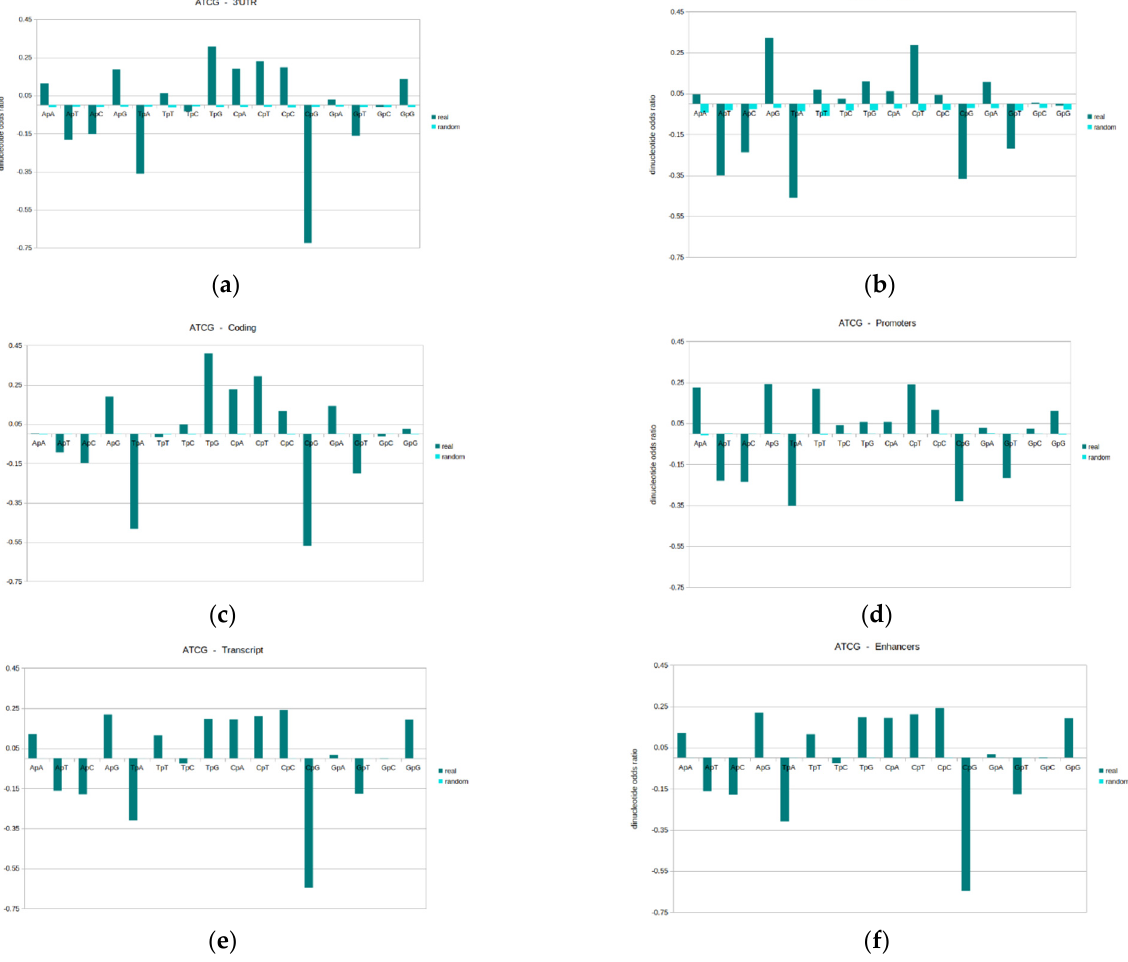
Figure 4. General designs profiles for the original ATCG sequence, according to genomic location These charts show the dinucleotide odds ratio profiles for the original ATCG sequence, in each of genomic sequence locations. These locations include the ( a ) 3 ′ UTR, ( b ) 5 ′ UTR, ( c ) coding, ( d ) promoter, ( e ) transcript, and ( f ) enhancer profiles. For each of these, the dinucleotides odds ratios are calculated for all possible 16 dinucleotides, and results here are the mean values (then standardized to 1) within the given genomic sequence type. In addition to the actual genomic DNA sequences, equivalent values for random-shuffled sequences are shown. A value of zero denotes the theoretical random model, and the further a value is from zero, the more distant that dinucleotide is from the random model. Each genomic sequence location possess a unique general design profile, which distinguishes it from all other sequence types. The most under-represented dinucleotide in all the sequence types is CpG followed by TpA. This is in-line with the general observation from genomic chromosomal DNA. The one exception is the promoter, where TpA is more strongly under- represented than CpG. This marks an important distinguishing feature of the promoter. Other under-represented dinucleotides include: ApT, ApC, GpT. The following dinucleotides are generally over-represented in the various sequence types: ApG, TpG, CpA, CpT, CpC, GpG. Additional odds ratio values that distinguish the promoter from the other genomic locations are that ApA, GpC, GpG, whilst not random, are close to this only in promoter. Features that distinguish between the promoter and enhancer are TpG, CpA, and CpC, which are more over-represented in the enhancer, and CpG, which is more suppressed in the enhancer. These general designs are extremely valuable both for potentially identifying the different sequences, and, importantly, for understanding their differences and how these relate to their particular functions in the genome.